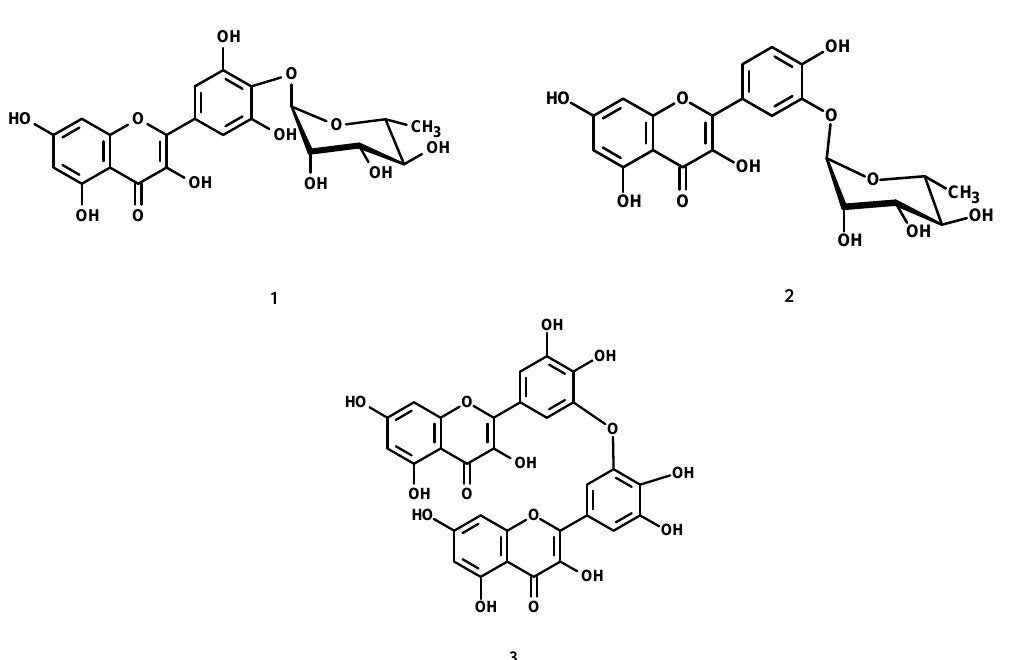
Figure 1. Structures of compounds 1 , 2 and